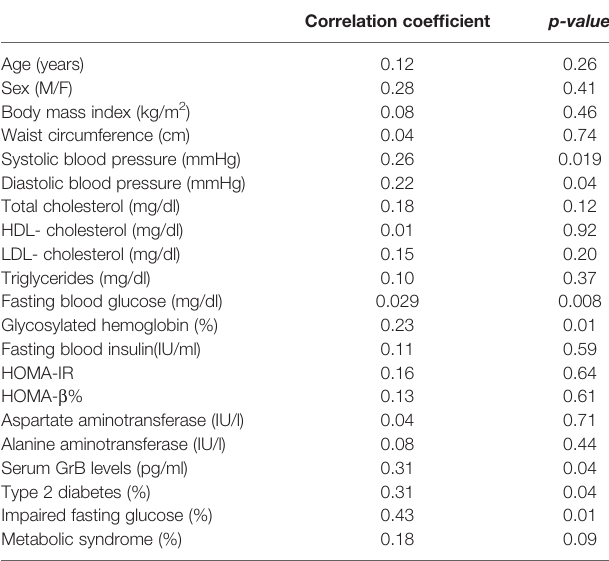
TABLE 3 | Correlation between Granzyme B (GrB) mRNA expression in visceral adipose tissue (VAT) and clinical and biochemical parameters in obese subjects (n = 85).